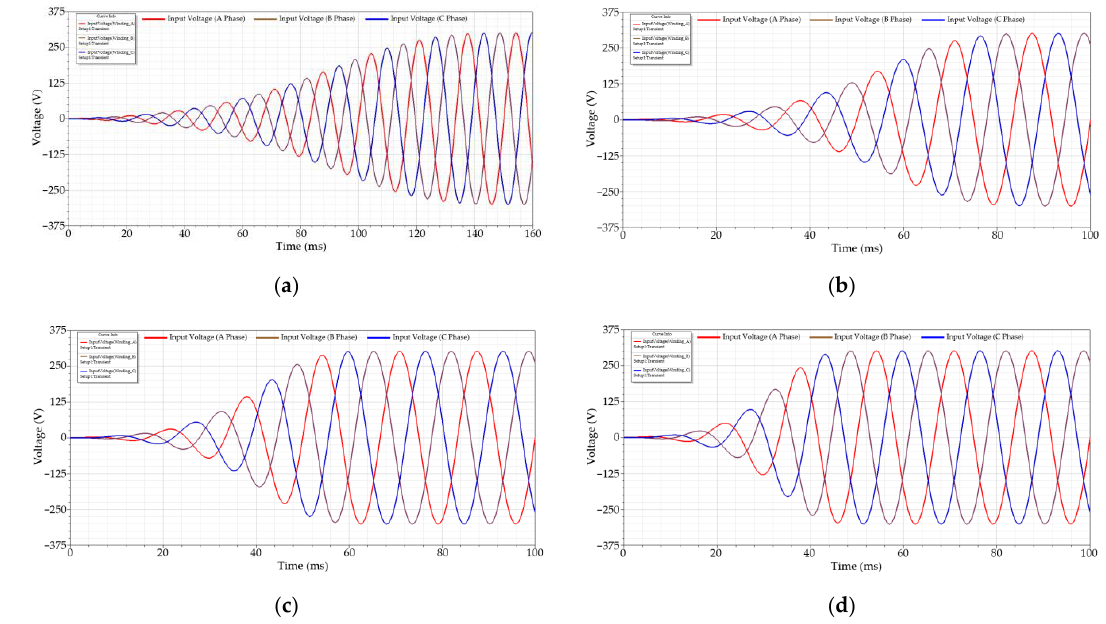
Figure 7. Simulation results of the winding voltage under the proposed equation. ( a ) 𝛾 = 25 ; ( b ) 𝛾 = 50 ; ( c ) 𝛾 = 75 ; ( d ) 𝛾 = 100.